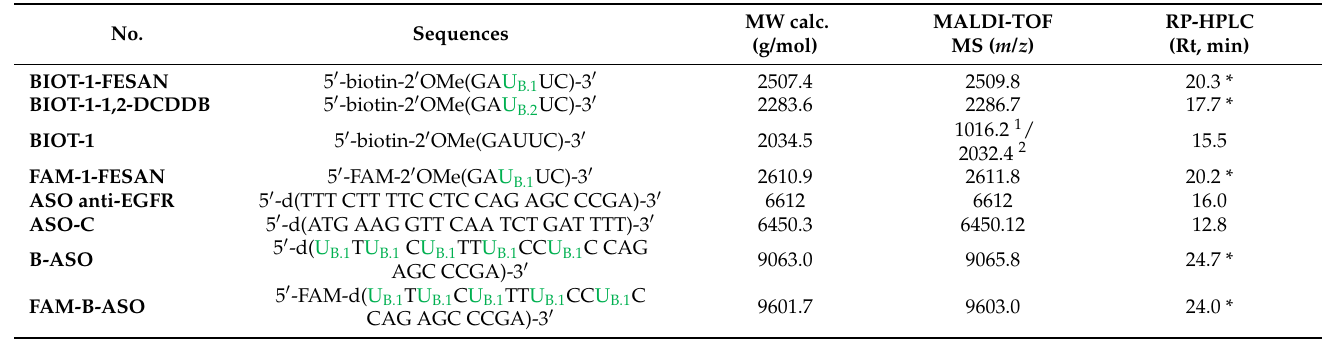
Table 1. Sequences, spectral (MS), and chromatographic (RP-HPLC) data of oligonucleotides modified (1) with: biotin (BIOT), uridine-boron clusters ( U B.1 -FESAN, U B.2 -1,2-DCDDB), or 6-carboxyfluorescein (FAM).